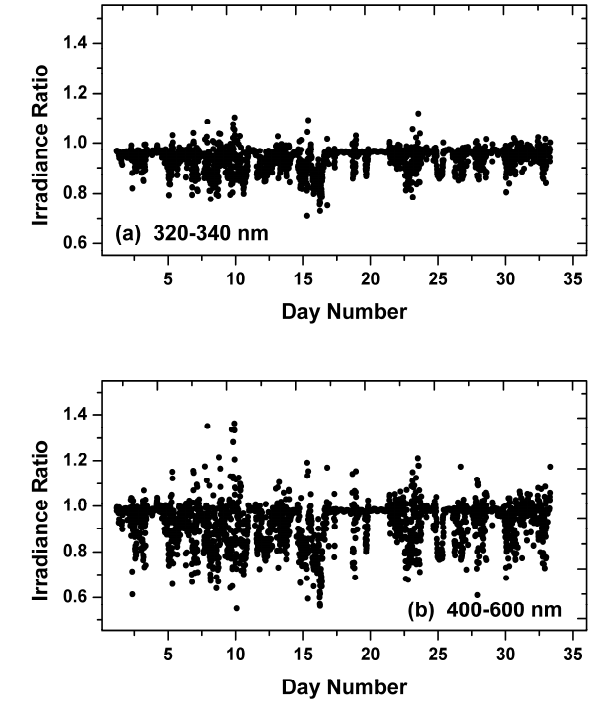
Fig. 3. Irradiance ratios for the solstice period December 2001 to January 2002, a relatively clear period: (a) 320–340nm wavelength band. (b) 400–600 nm wavelength band. Day number 1 is 7 De- cember 2001.